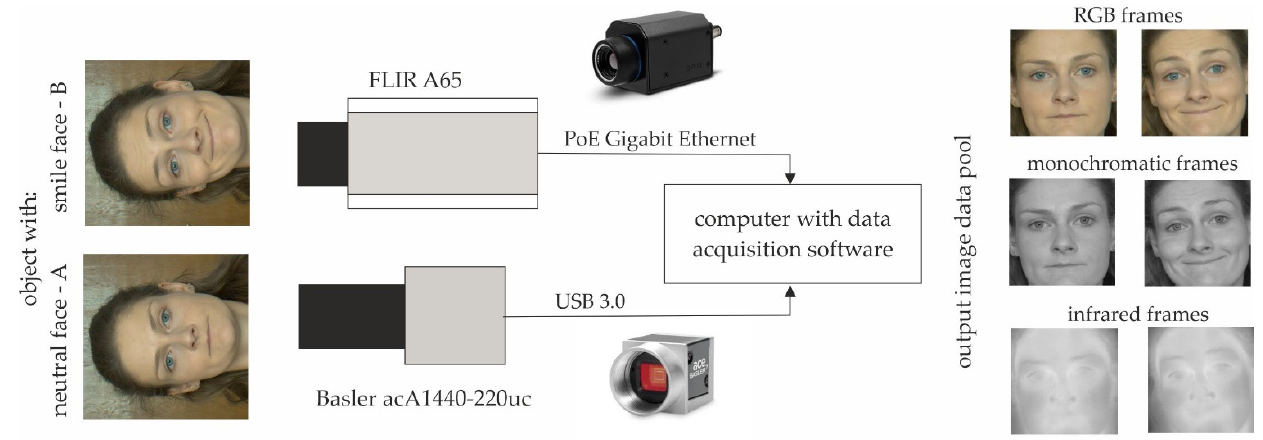
Figure 1. The set used for image acquisition.